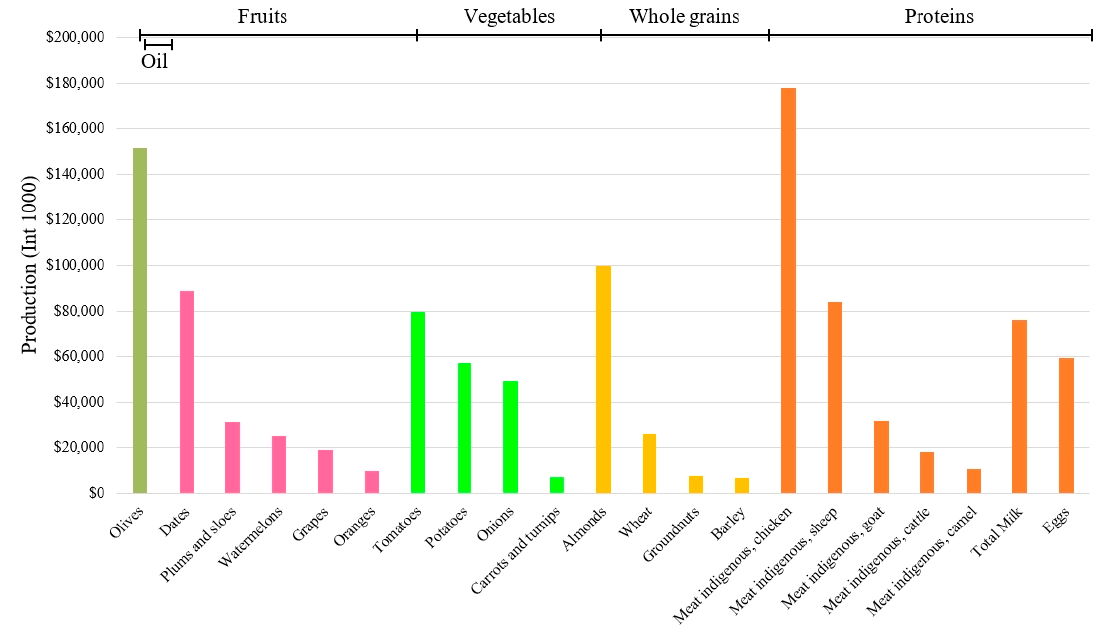
Figure 5. Values of crops produced in Libya in 2016 [34] in relation to the Healthy Eating Plate [33].